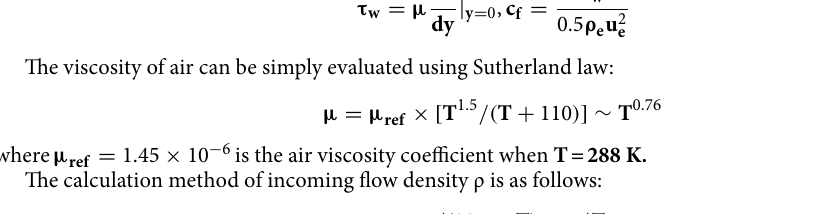
transition and friction drag in turbulent boundary layer. Figures 10 and 11 show the contours of the friction stress coefficient distribution on the upper and lower surfaces for different temperature gradients. Under various wall temperature gradients, the laminar flow areas at the leading edge of the model are small because the model has a large sweep angle of 65°. With the simultaneous change of wall temperature gradient, the laminar flow area and the friction coefficient of the model surface change according to a certain law. The flow in the middle wing section is the main concern in the analysis to reduce the influence of the fuselage flow with large thickness on the flying wing. On the adiabatic wall, the laminar flow range of the upper wing decreases at lower wall tempera- ture. The hot wall is opposite to the cold wall, the transition region moves backward and the laminar flow range increases. While the lower airfoil is under the influence of the forward pressure gradient, which is similar to that of the upper airfoil due to the wall temperature gradient, and the effect of laminar flow range is more obvious. Temperature gradient not only affects the transition behavior of the laminar boundary layer, but also affects the friction coefficient in turbulent region, which shows apparent variation law with wall temperature. Turbulent flow after transition in the case of cold wall has a larger friction drag coefficient and smaller friction drag in the case of hot wall.